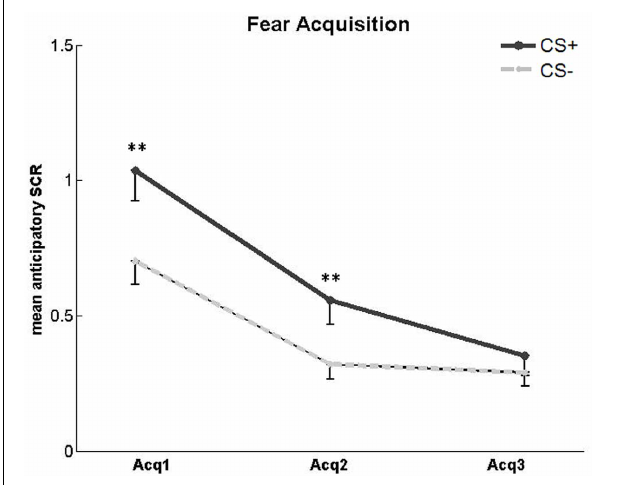
FIGURE 3 | SCR in the acquisition phase. Significantly higher mean SCR to unreinforced CS + compared to CS − in the first and second, but not third, fear acquisition (Acq) run. Asterisks indicate significant difference. Error bars represent standard error.